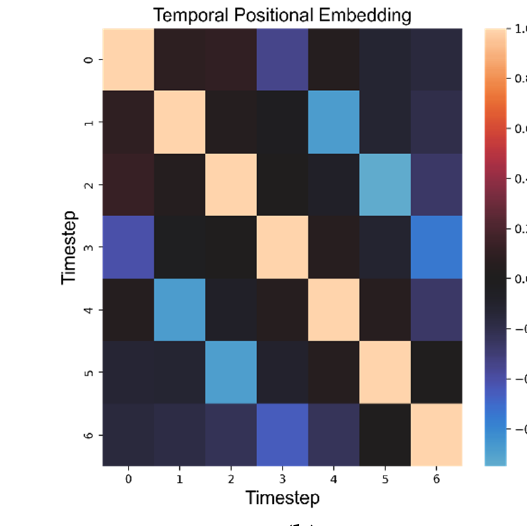
( b ) Figure 9. Cosine similarity of spatial position embedding. ( a ) The left side shows the position em- bedding for the encoder block. ( b ) The right side shows position embedding for the decoder block.